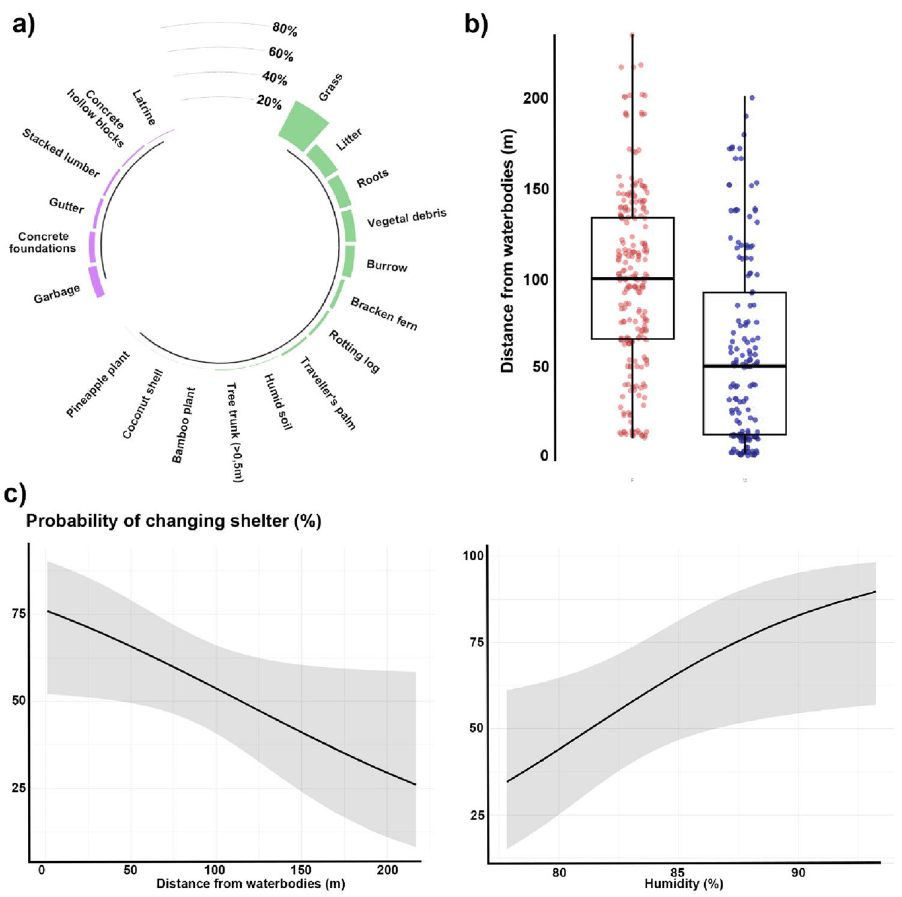
Figure 4. Sheltering behaviour of the Asian common toad in Toamasina (Madagascar). ( a ) Type of shelters (in green natural shelters, in purple anthropogenic shelters); ( b ) boxplot of distances of shelters from the nearest water bodies (in blue—right—males, in red—left—females); ( c ) predicted probability of changing shelter in relation to the distance from the nearest permanent water body (left) and in relation to humidity